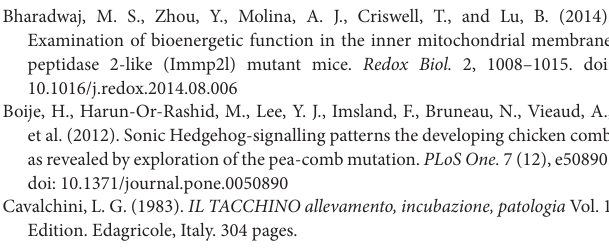
sUPPleMeNTARY TABle s1 | CNVs identified in each Turkey population. sUPPleMeNTARY TABle s2 | CNVRs with at least 2 individuals and detected in more than one turkey population. sUPPleMeNTARY TABle s3 | Singleton CNVRs.